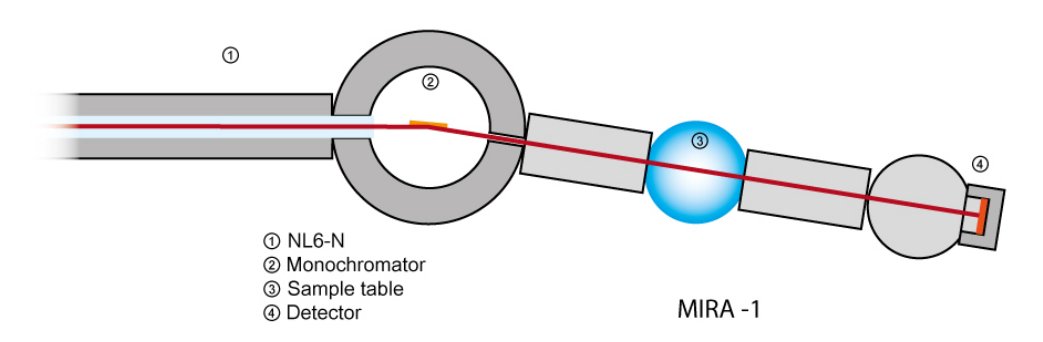
Figure 2: Schematic drawing of